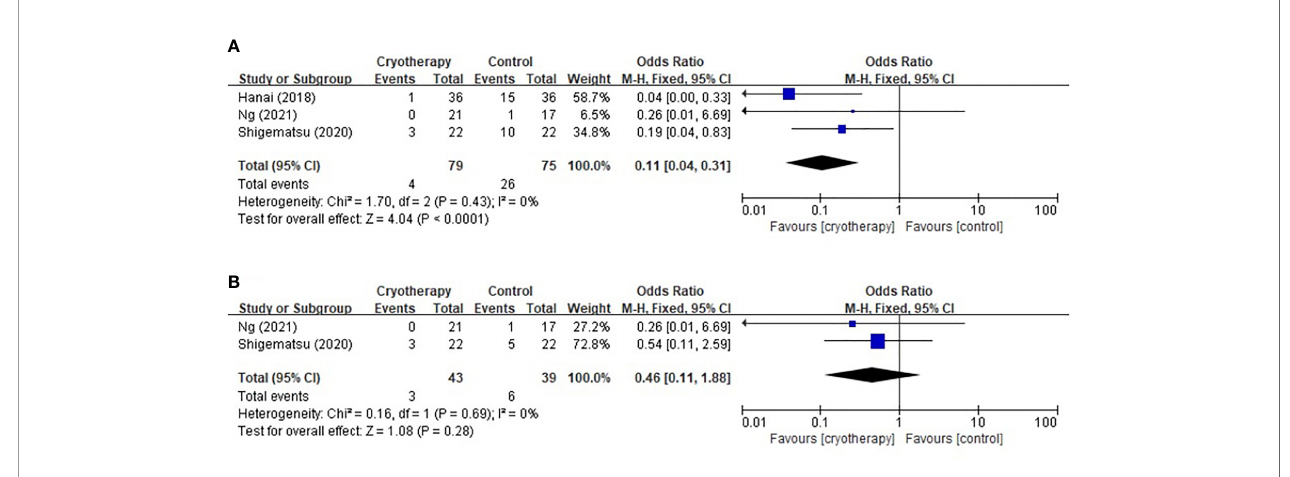
FIGURE 3 | Forest plots of the preventive effects of cryotherapy on TIPN evaluated by PNQ ≥ grade D. (A) sensory neuropathy; (B) motor